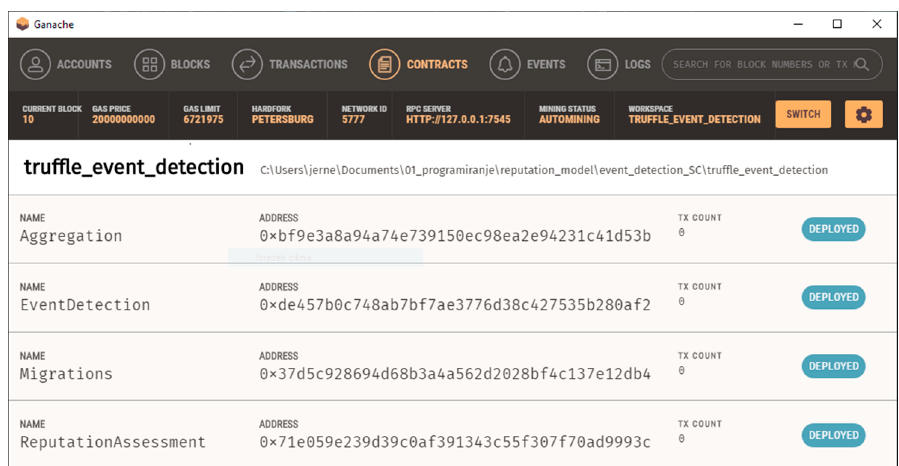
Figure 5. Ganache environment for local smart contract deployment and testing.